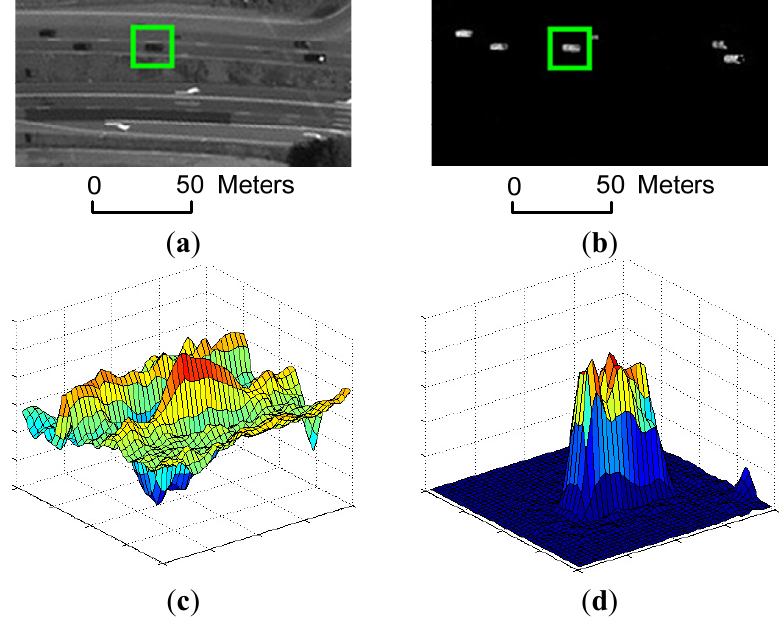
Figure 8. Vehicle (negative polarity) extraction results: ( a ) original image; ( b ) candidate location; ( c ) 3D distribution of vehicle and surroundings in the original image; ( d ) 3D distribution of the vehicle and surroundings in the resulting image.